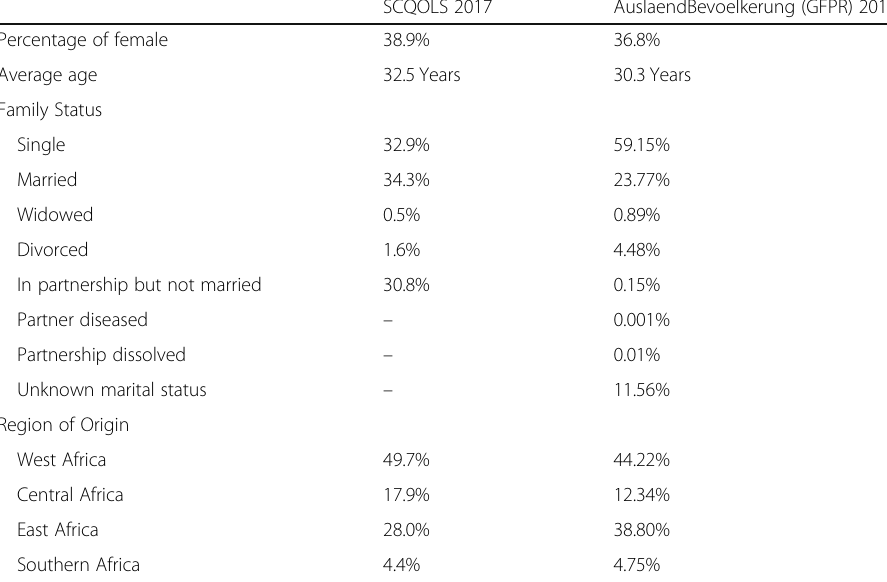
Table 1 Comparison of AuslaendBevoelkerung (German Foreign Population Report - GFPR) 2016 and Social Capital and quality of life survey (SCQOLS) 2017 by Sex ratio, Average age, and Family SCQOLS 2017 AuslaendBevoelkerung (GFPR)